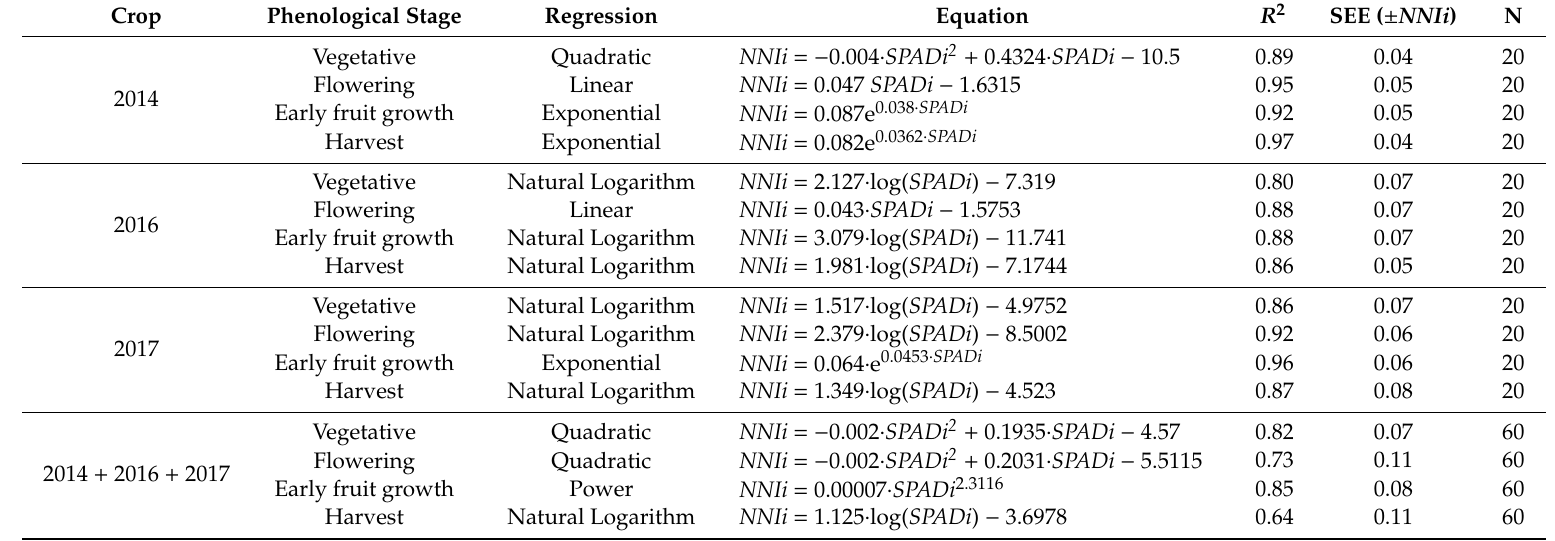
Table 6. Coe ffi cients of determination (R 2 ) of regressions between integrated SPAD ( SPADi ) values and integrated nitrogen nutrition index ( NNIi ) for each phenological stage in each of the three sweet pepper ( Capsicum annuum ) crops independently, and for the three crops together. Each crop was subjected to five di ff erent N treatments with four repetitions. According to the Akaike information criterion, the best-fit regression model (exponential, linear, power, quadratic, and natural logarithm) is shown. Also, the fitted equation and standard error of the estimate (SEE) are presented. All regressions were highly significant at p -value < 0.001. N is the number of data points of